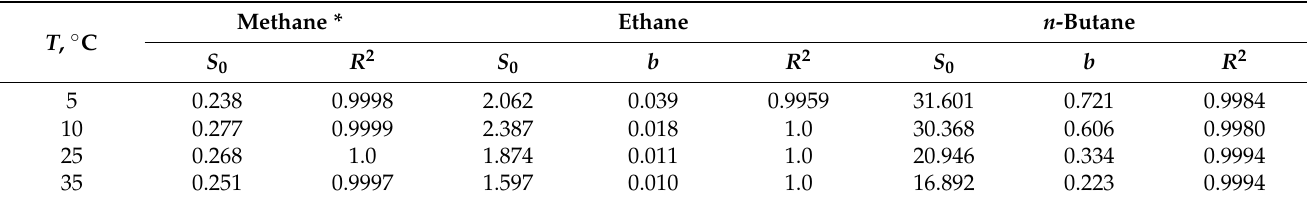
Table 1. Fitting parameters of Equation (8) for CH 4 , C 2 H 6 and n -C 4 H 10 at different temperatures